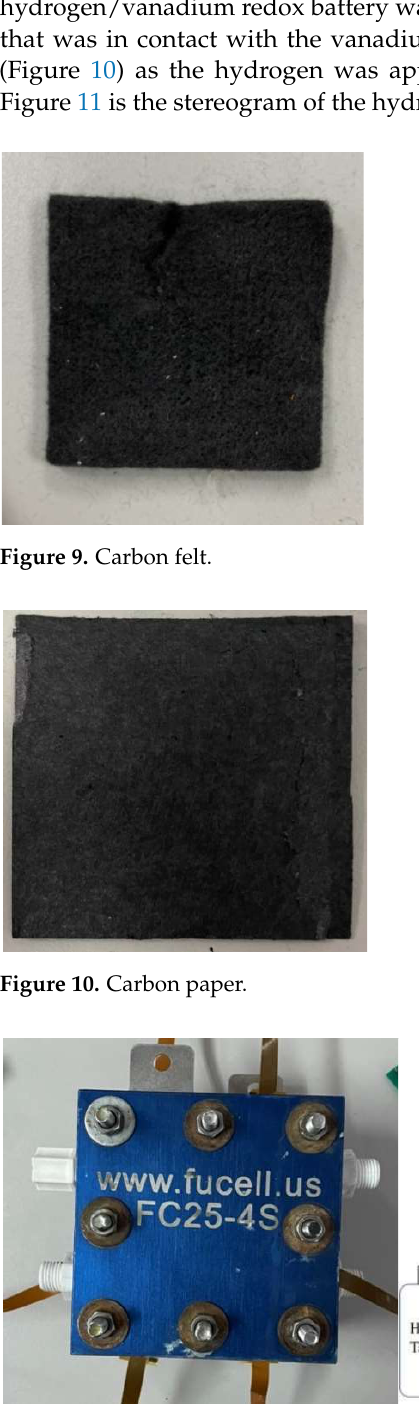
Figure 11. Stereogram of the hydrogen/vanadium redox battery and schematic diagram.